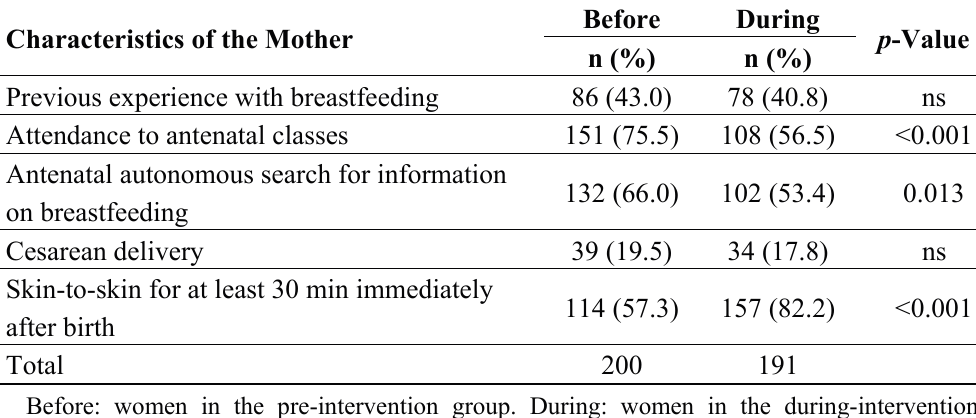
Table 1. Characteristics of the